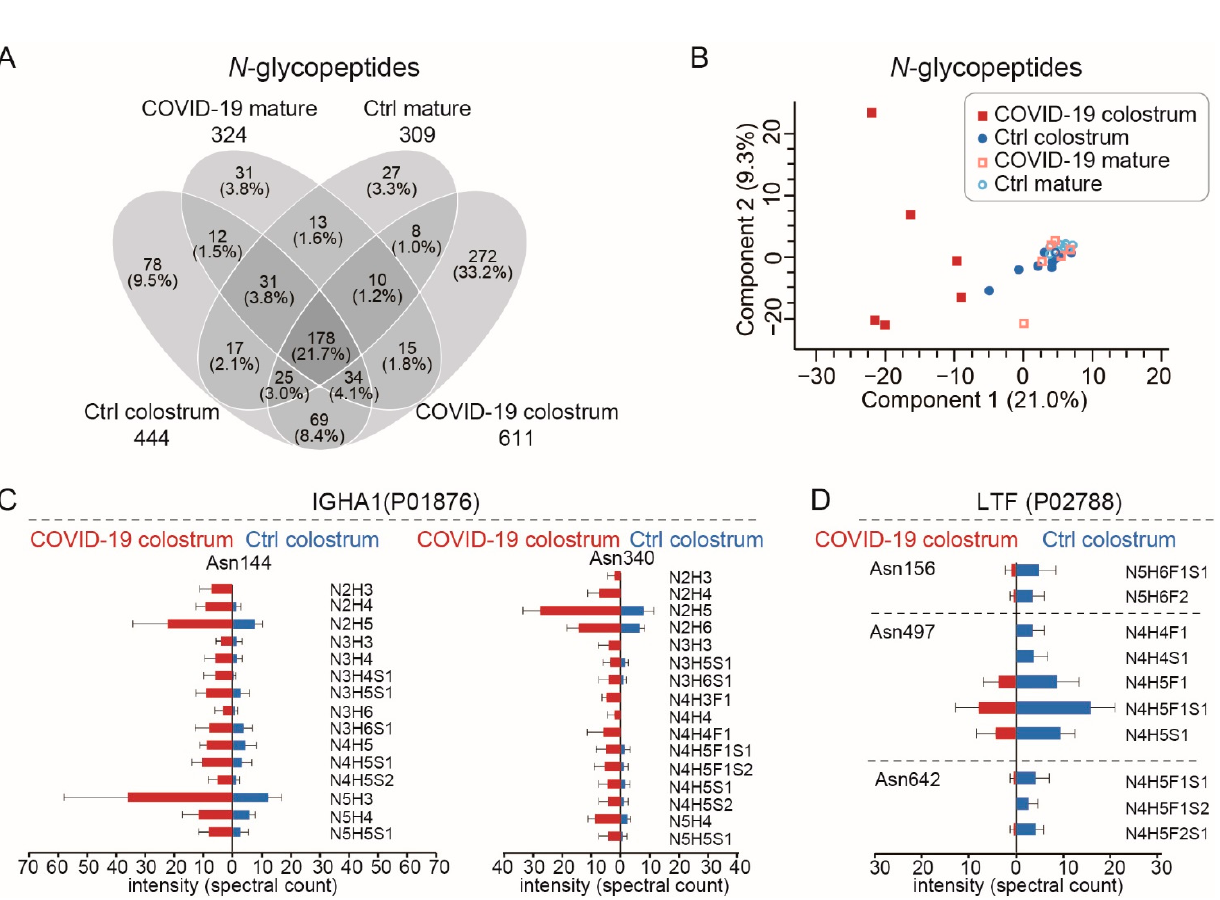
Figure 3. The glycoproteomes of each sample group. ( A ) A Venn diagram showing the numbers of N -glycopeptides that could be quantitatively monitored. The numbers of N -glycopeptides for each group are shown below the group name. ( B ) Principal components analysis plot of N -glycopeptides. ( C , D ) Site-specific changes in N -glycopeptides of IGHA1 (immunoglobulin heavy constant alpha 1) ( C ) and LTF (lactoferrin) ( D ) between COVID-19 colostrum and Ctrl colostrum groups. Bars indicate means and whiskers indicate SDs.